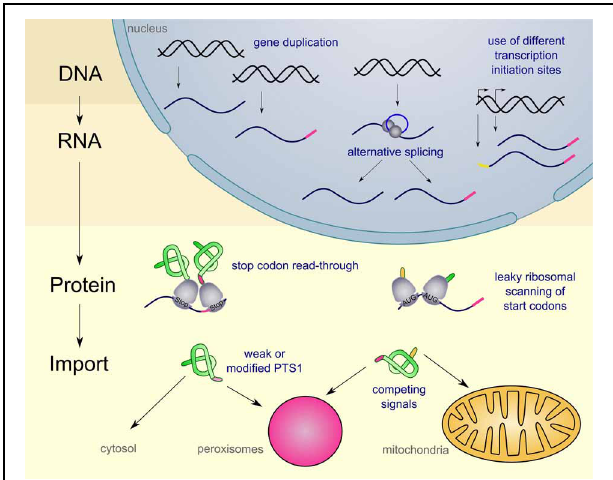
FIGURE 1 | Schematic overview on the diversity of mechanism leading to dual targeting of peroxisomal proteins. Peroxisomal targeting signals are indicated in pink, while mitochondrial signal sequences are indicated in yellow. For further explanations see